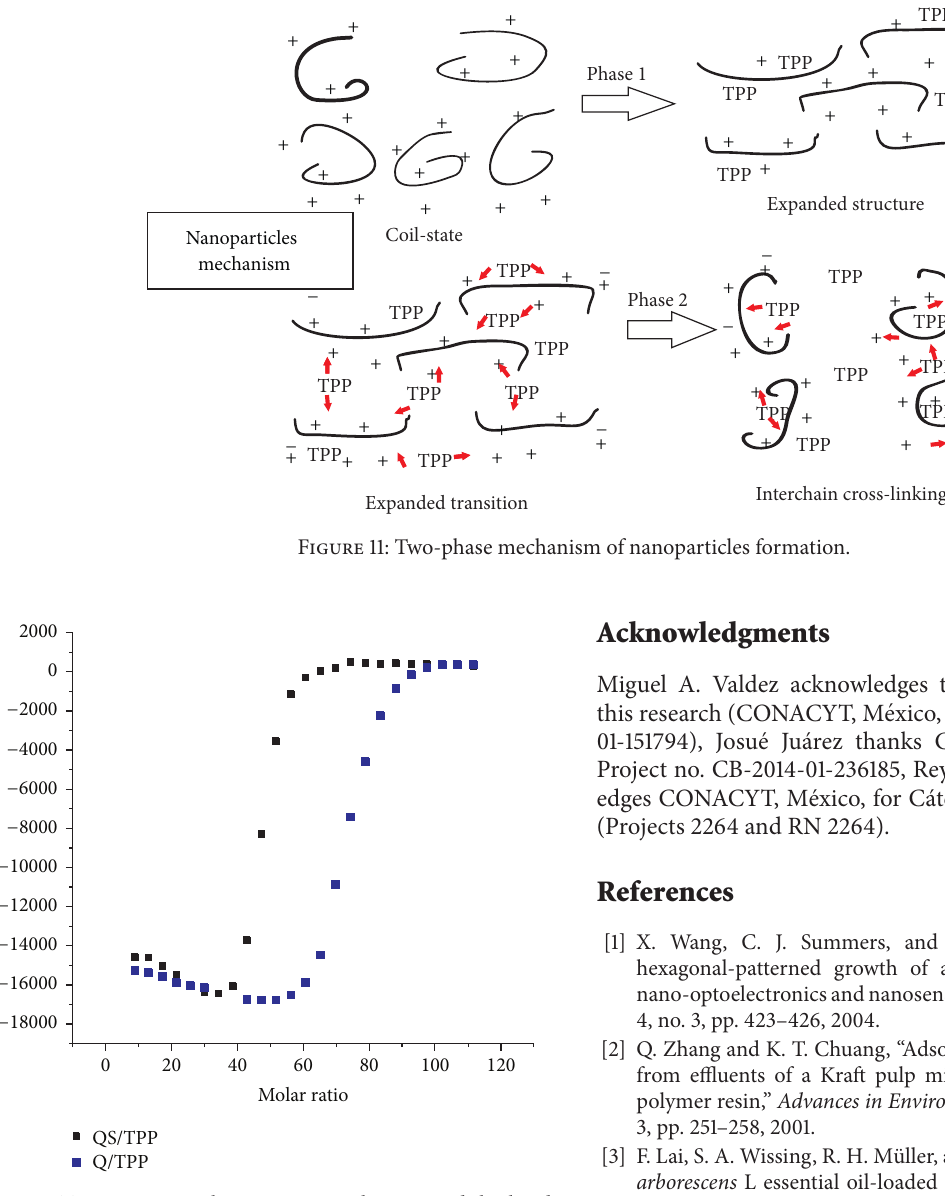
Figure 12: ITC comparative between native chitosan and thiolated